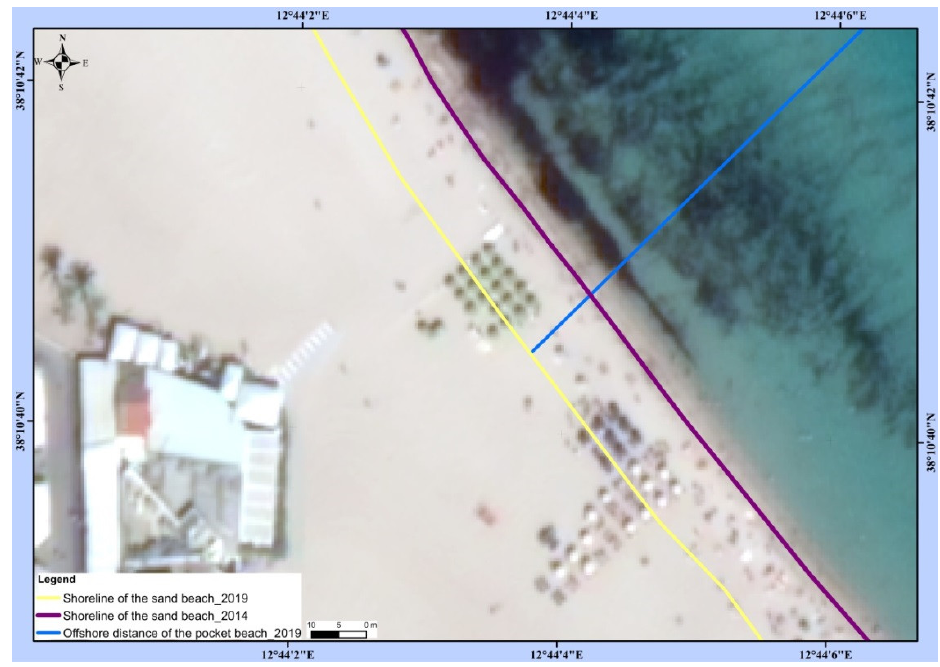
Figure 7. Map of 2019 and 2014 sand beach shorelines positions overlapped on the GeoEye-1 satellite image acquired on 18 October 2014 on the coast of San Vito Lo Capo. Note the offshore distance between 2014 and 2016 shorelines, indicating the migration of 15 m length of the sand beach.